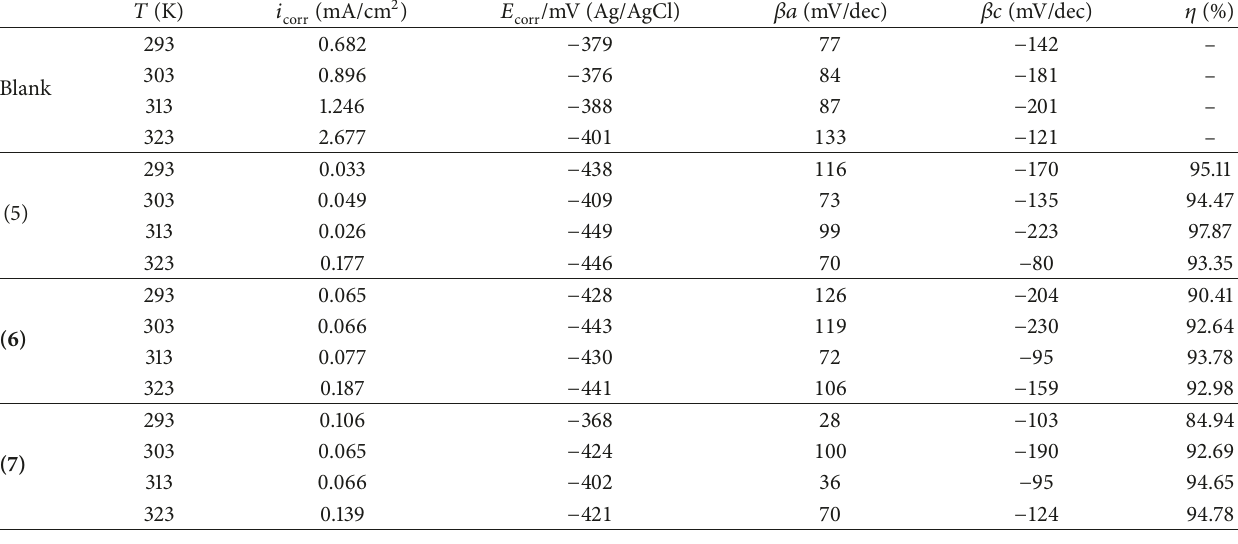
Table 5: The influence of temperature on the electrochemical parameters for steel electrode immersed in 1MHCl and 1MHCl + 5mmol/L of inhibitors.